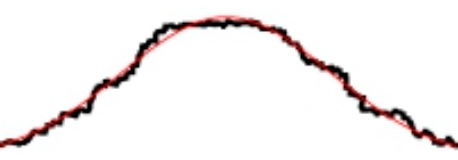
Figure 11. The fitting result of gaussian distribution function.